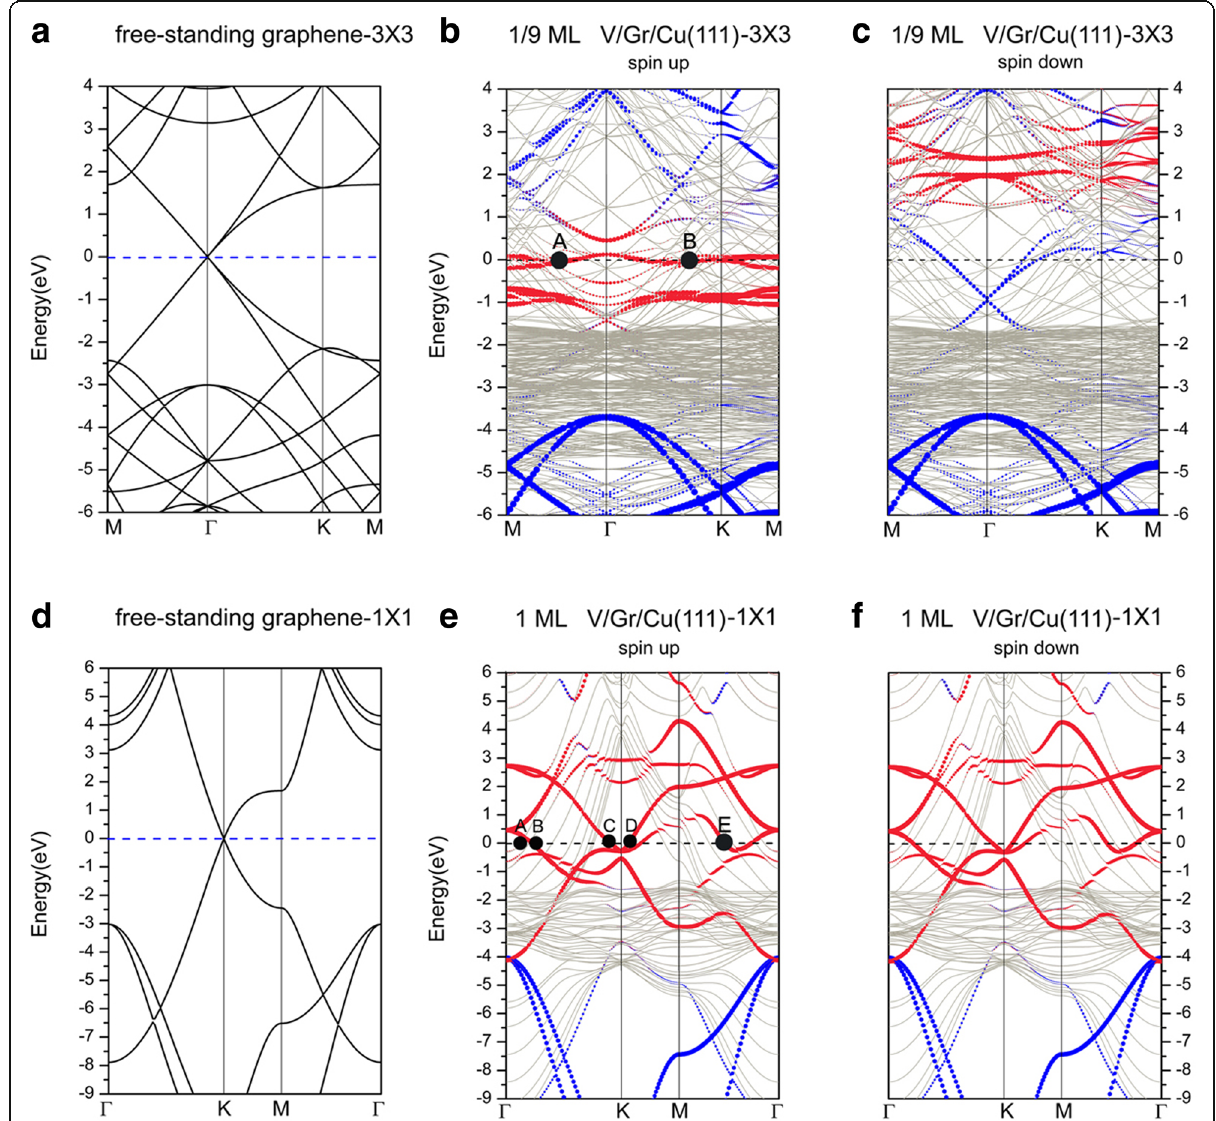
Fig. 8 Band structures of a free-standing graphene, plotted in the Brillouin zones of a a (3×3) unit cell and d a (1×1) unit cell. Band structures of V adsorptions on the graphene-covered Cu(111) surfaces for b spin up of 1/9 ML, c spin down of 1/9 ML, e spin up of 1 ML, and f spin down of 1